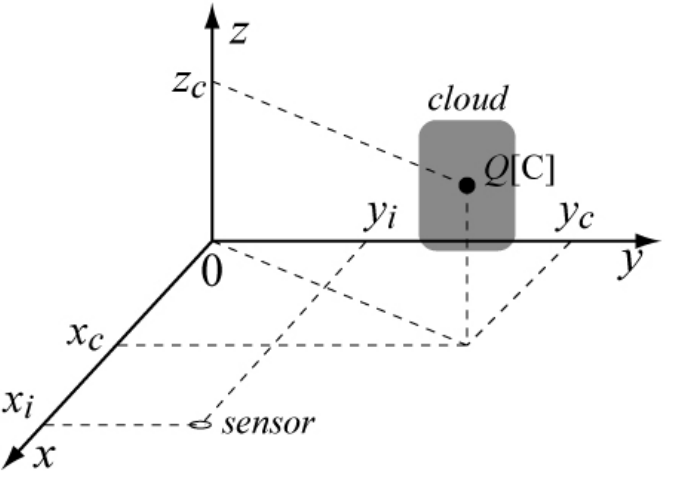
Figure 7. Coordinate system of the point charge model inside an isolated thundercloud.